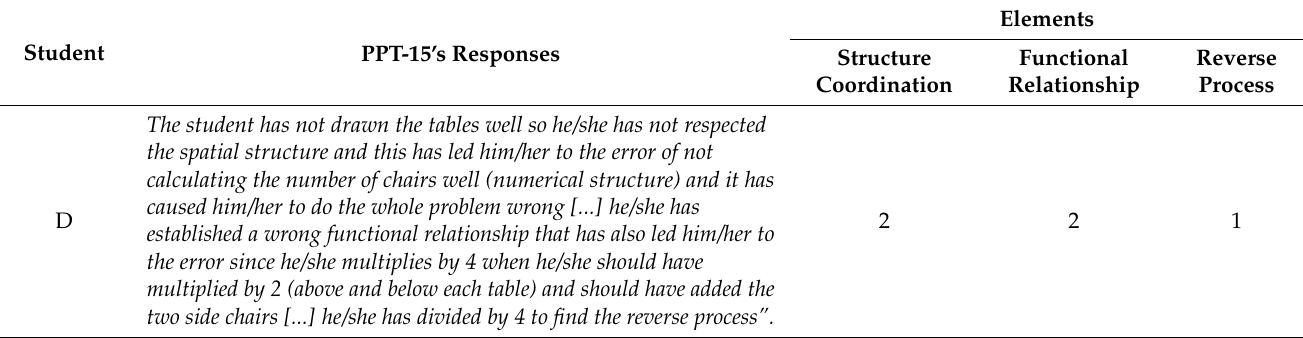
Table 11. PPT-15’s responses from Profile